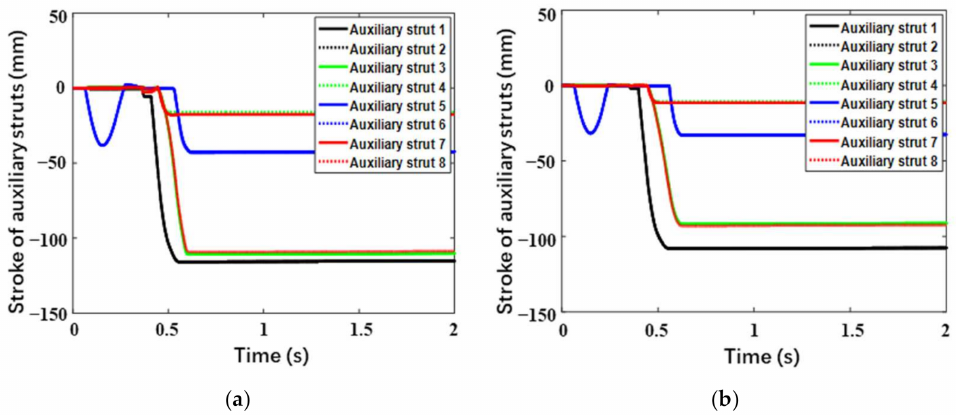
Figure 14. Stroke of auxiliary struts versus time for ( a ) buckypaper-buffering lander and ( b ) alu- minum honeycomb-buffering lander.